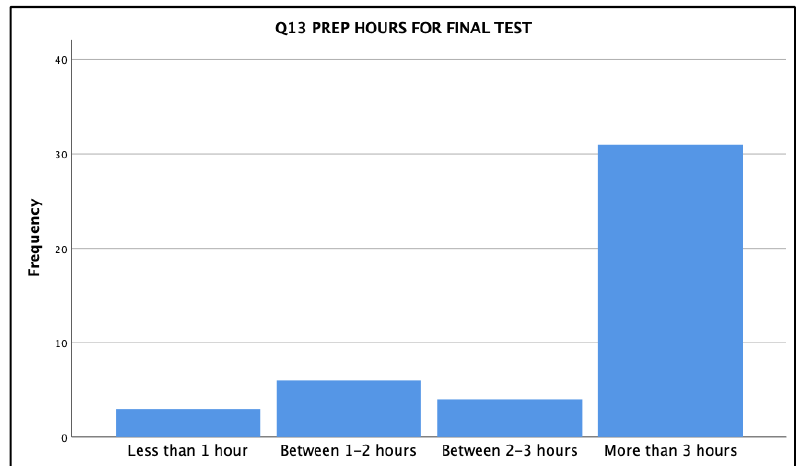
Figure 3. Number of hours, on average, spent on preparing for final dosage